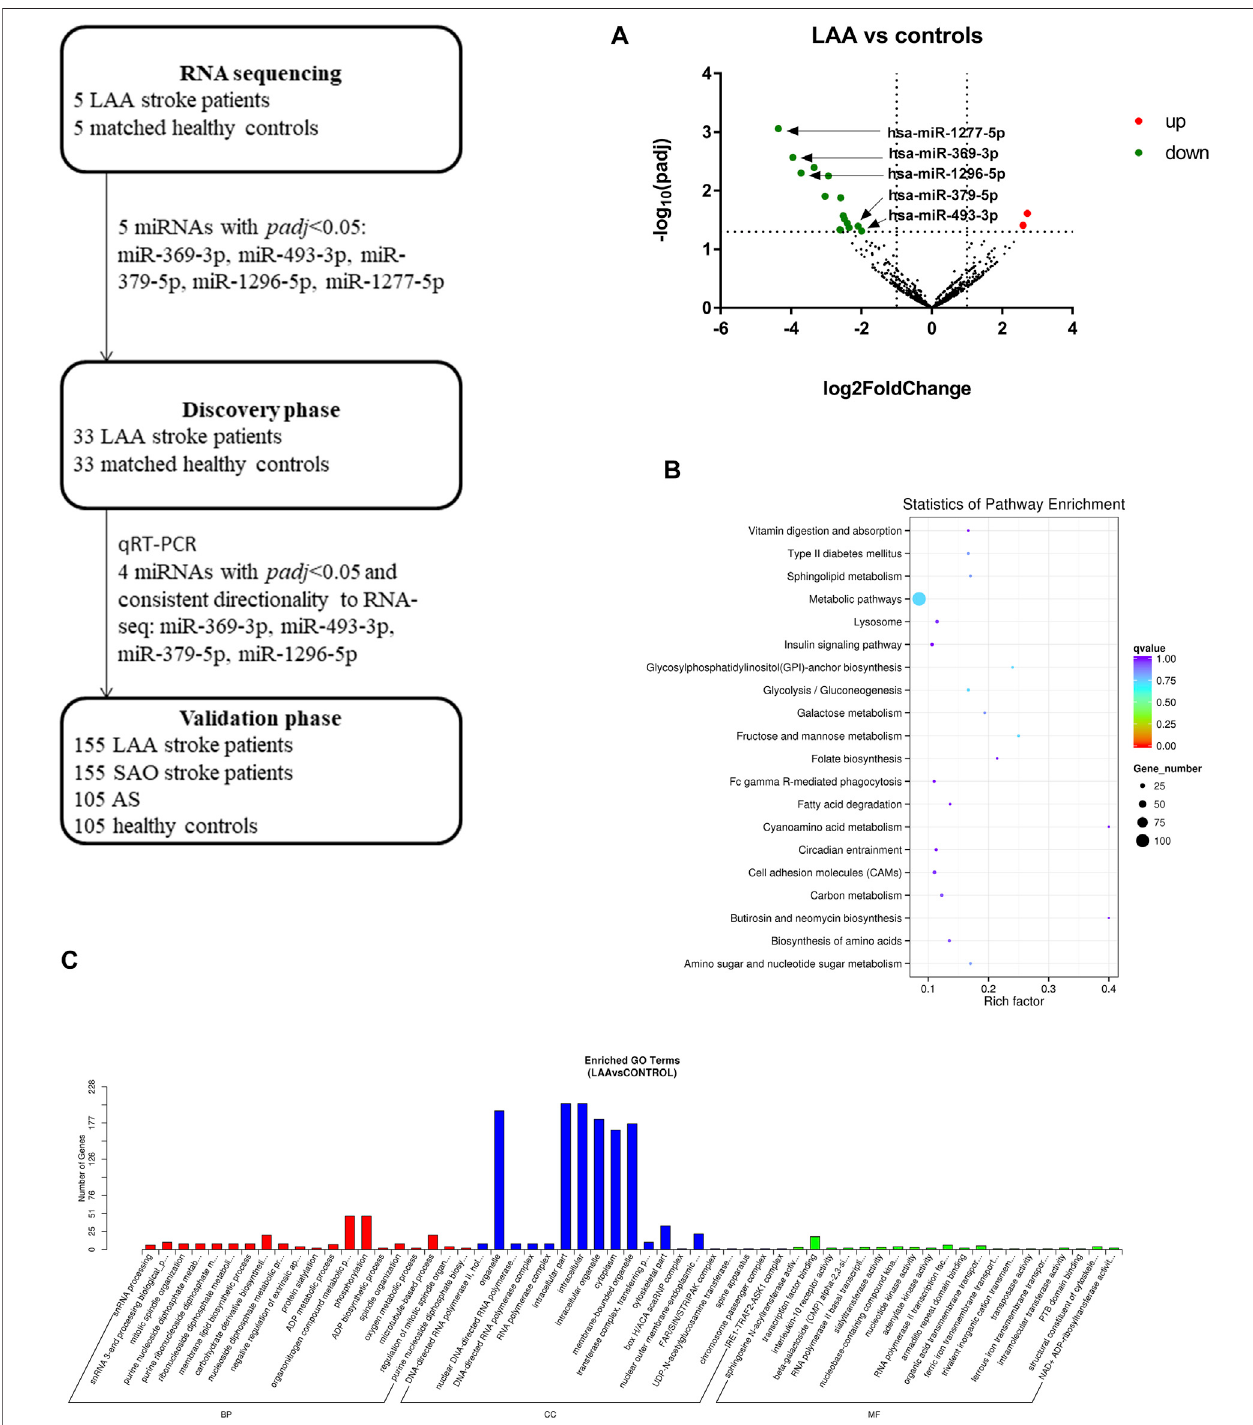
FIGURE2| Work fl owandRNAsequencingresults.TargetanalysisofmiRNAsdifferentiallyexpressedinenrichedexosomefractionsfromLAAandcontrolplasma samples. GO/KEGG enrichment was performed on differentially expressed miRNAs identi fi ed in exosome-enriched plasma, and miRNA analysis was performed. (A) . Volcano map showingthehigh-throughput sequencing results forLAAvs. healthycontrol samples; redindicates upregulation,and greenindicates downregulation. (B) . Bubble plot of the KEGG pathway enrichment results. (C) . Bar plot of the GO enrichment results (biological process, cellular component, and molecular function